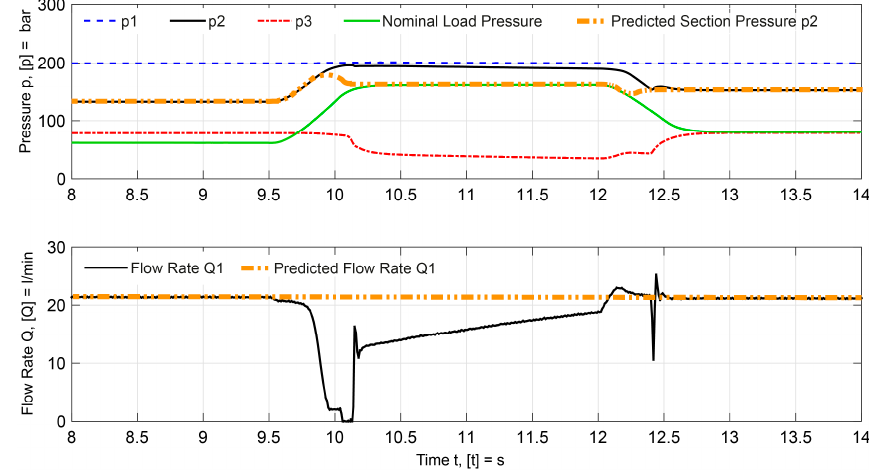
Figure 12. Verification of the T/A-LV prototype. Previously disclosed in [17]. Reproduced with permission from the publisher.